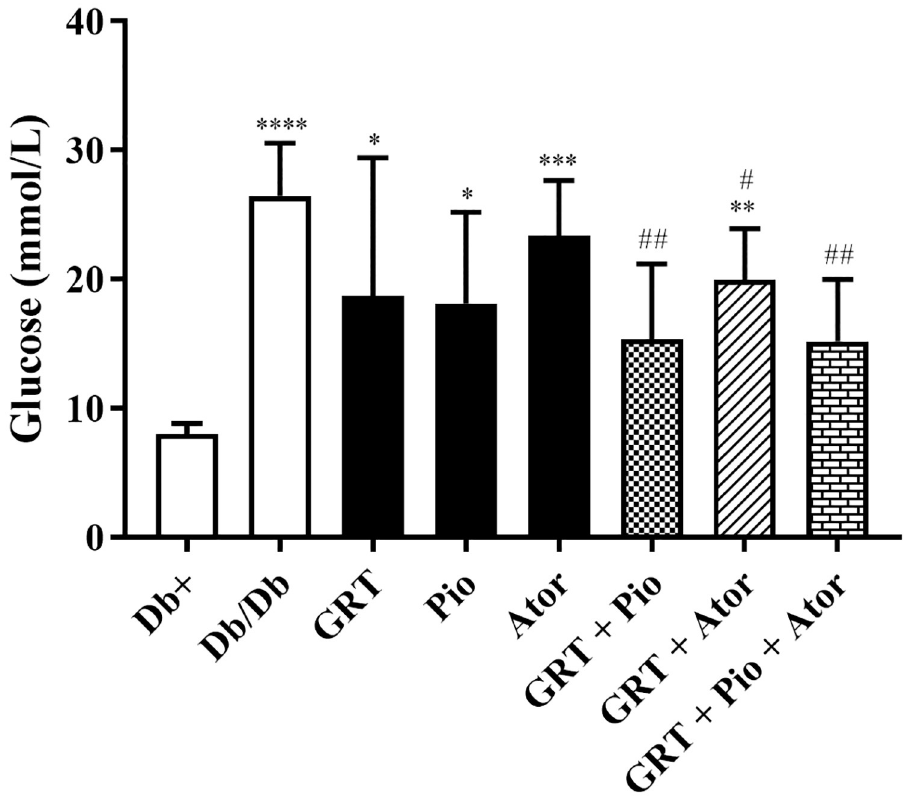
Fig 1. The effect of GRT (100 mg/kg BW), Pio (25 mg/kg BW), and Ator (80 mg/kg BW) mono- and co-therapies on FPG. Glucose measured after 5 weeks of treatment. Results are expressed as the mean ± SEM (n = 6). � p < 0.05, �� p < 0.01 and ���� p < 0.0001 vs db+ ; # p < 0.05 vs db/db (One-Way ANOVA followed by Dunnett multiple comparison test). FPG, fasting blood glucose; GRT, green rooibos extract; Pio, pioglitazone; and Ator,